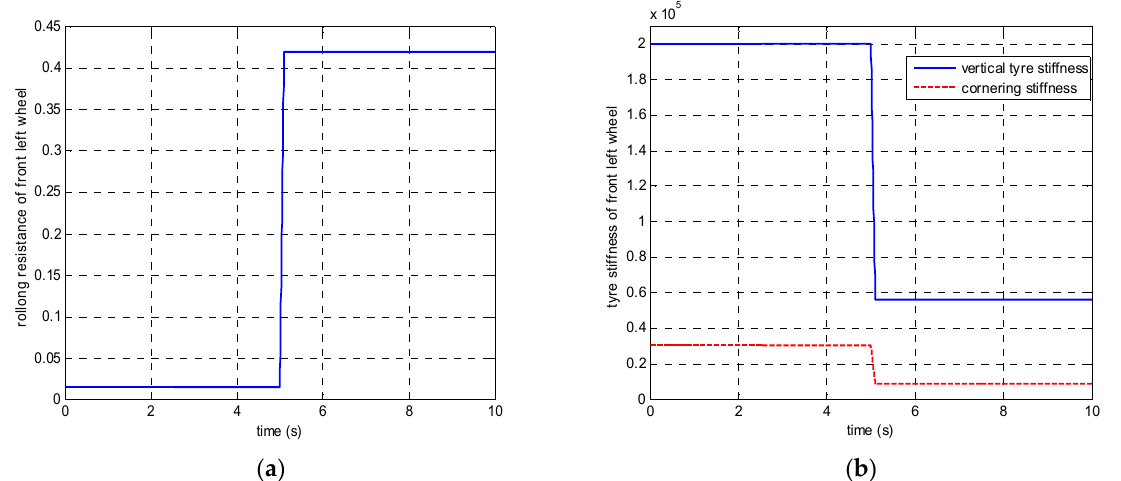
Figure 14. The changing of front-left tyre parameters after tyre blow-out in the second set of simulations ( a ) rolling resistance, ( b ) tyre vertical and cornering stiffness.